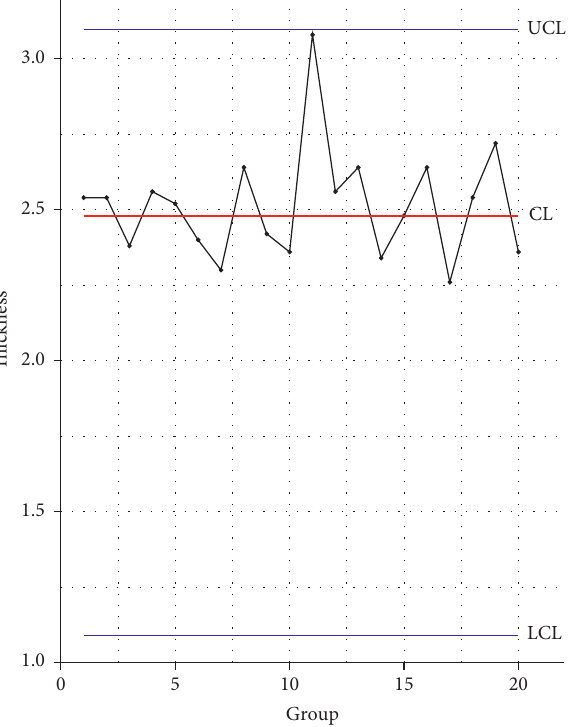
Figure 6: Gompertz exact X control Table 4: Performance index values.